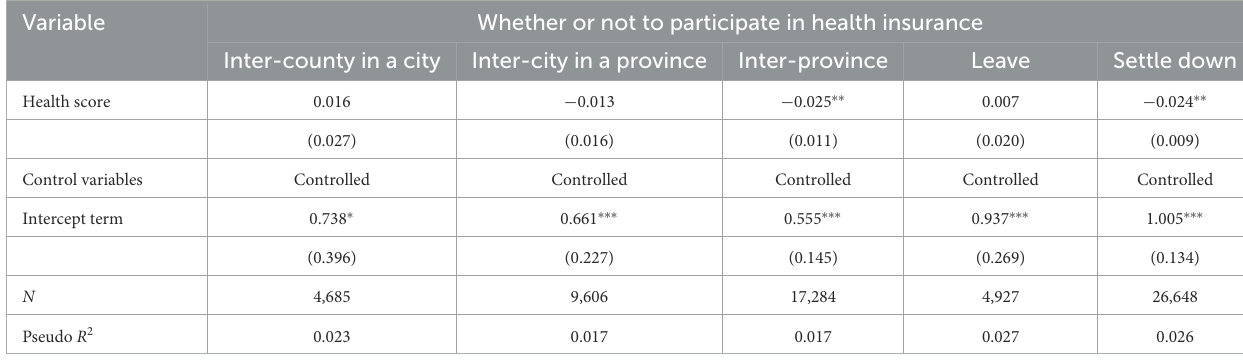
TABLE 7 Heterogeneous effect of mobility distance and settlement intention on adverse selection in health insurance participation. Variable